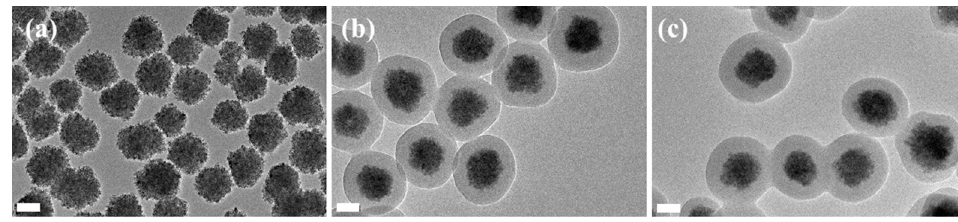
Figure 3. TEM images of ( a ) MSP (magnetic supraparticle); ( b ) MSP@PNAMAm- p ; ( c ) MSP@PNAMAm. The scale bar is 100 nm.